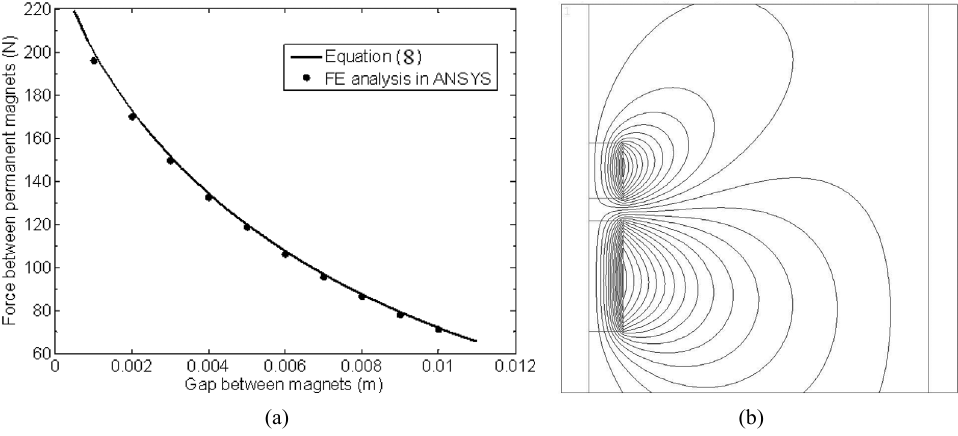
Fig. 7. (a). Force-gap plot for a single actuator; (b). Two-dimensional fl ux lines between two permanent magnets for a gap of 10 mm obtained from an axisymmetric fi nite element analysis in ANSYS.